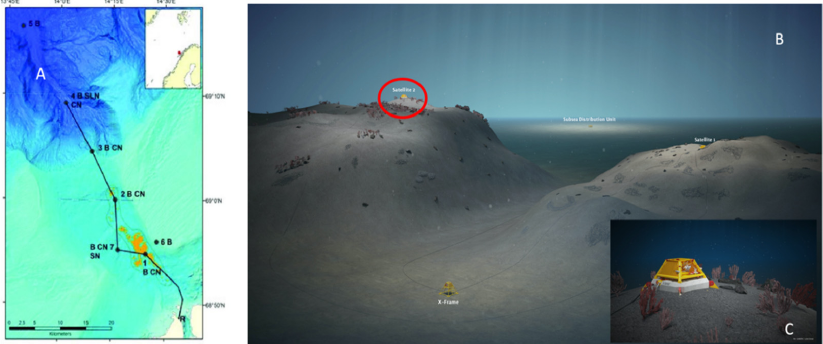
Figure 1. Overview of the Lofoten-Vesterålen (LoVe) canyon area (from Aguzzi et al. [6]). ( A ) The bathymetric map with the extended cabled transect with nodes (black dots) numbered 1–7 for shallower (light blue) to deeper realms (dark blue) and connected by a marine cable (continuous line). Node 1 is located in the shallowest part of the trough (orange areas represent the cold water coral (CWC) reefs). ( B ) A 3D detailed representation of the area around Node 1, where satellite no. 2 with camera appears on top of a small mound (encircled in red). ( C ) Enlarged view of the areas surrounding the satellite #2, where Paragorgia colonies are schematized.